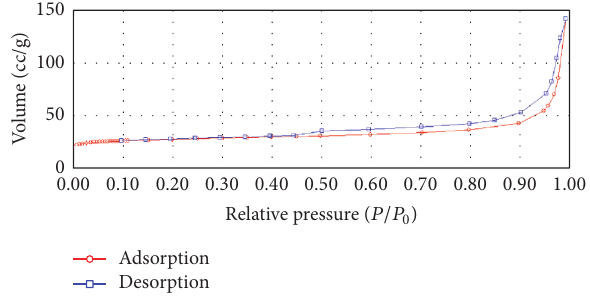
Figure 6: Adsorption/desorption of nitrogen gas on PAC.